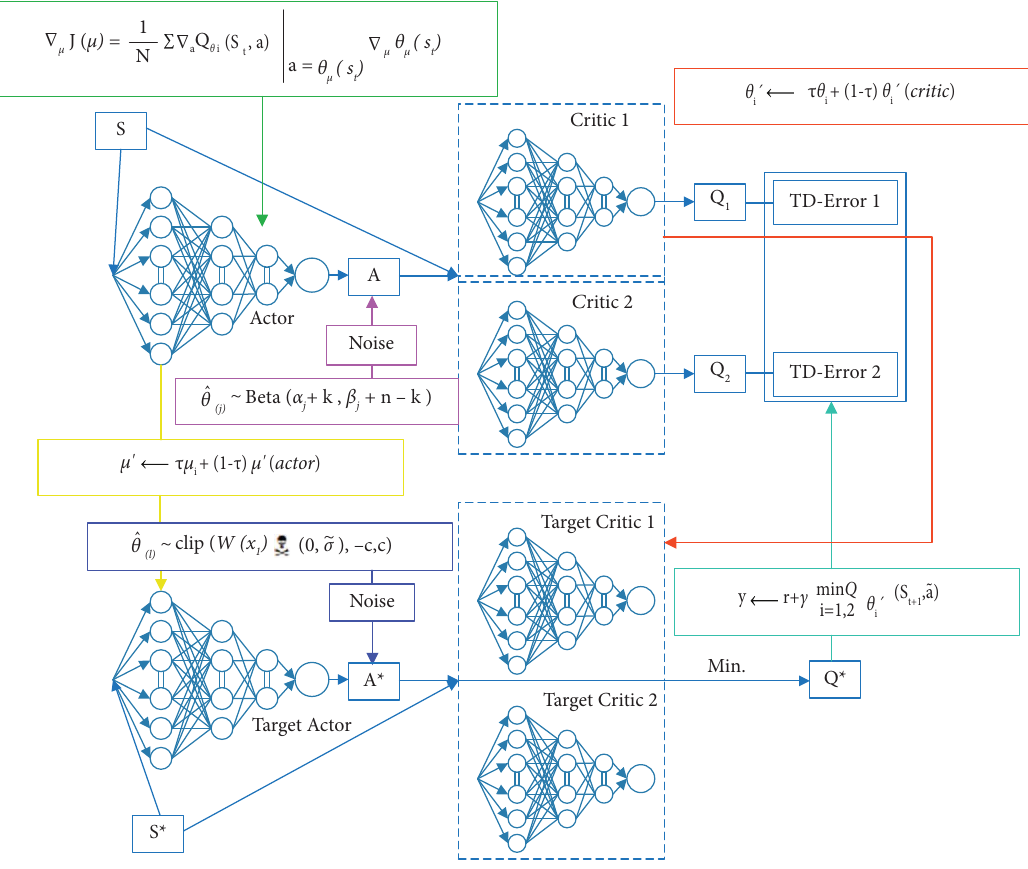
Figure 2: Te architecture of the improved